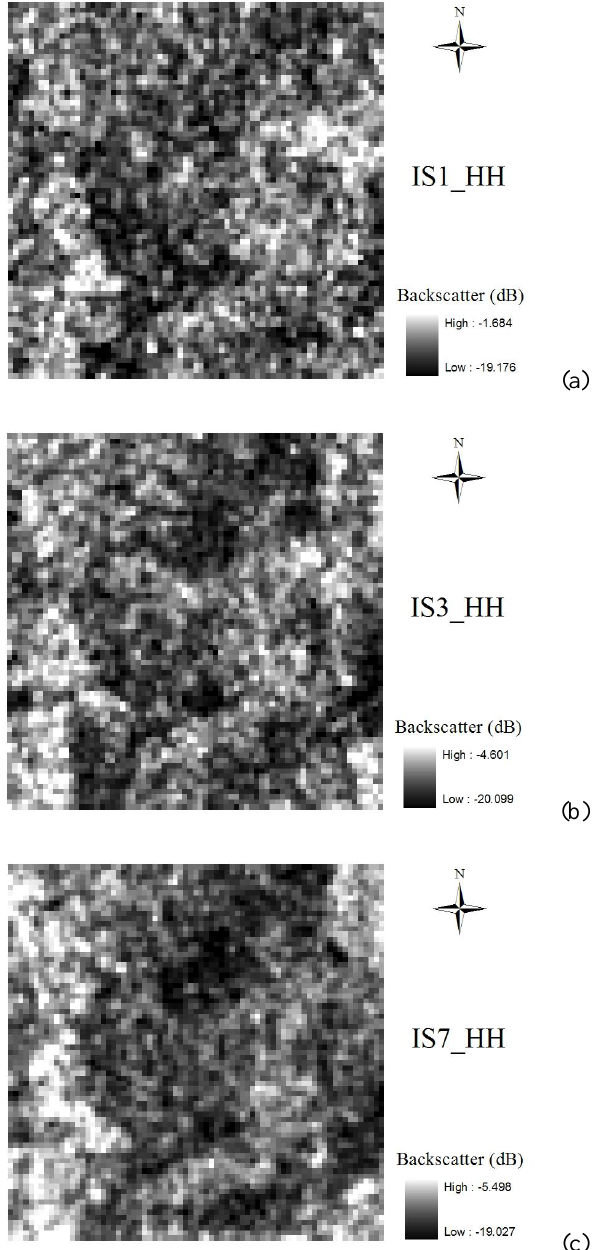
Figure 3. Segment scenes of the processed images in the regions of the study area, (a), (b), and (c) corresponding to the IS1, IS3, and IS7 swaths, respectively.